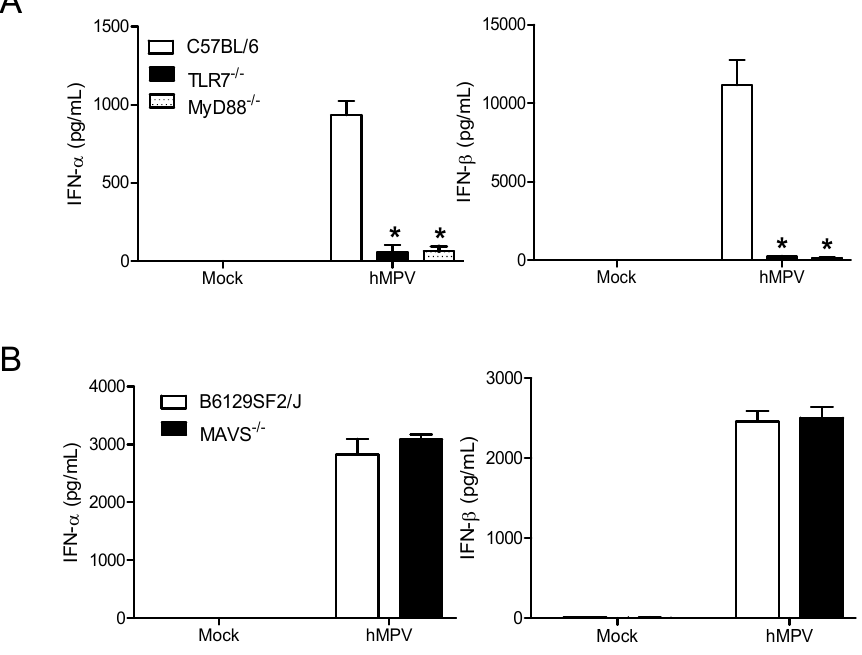
Figure 2. hMPV induced type I interferon in pDCs is TLR-7/MyD88 dependent. Spleen pDCs isolated from C57BL/6, TLR7-/- and MyD88-/- mice ( A ) or B6129SF2/J or MAVS-/- mice ( B ) were infected with hMPV (MOI 3) and supernatant was harvested at 24h p.i. to measure IFN-α and -β production by ELISA. Each bar represents mean ± SEM ( n = 4 animals/group) and representative of three independent experiments. * p < 0.05 relative to wild type cells.